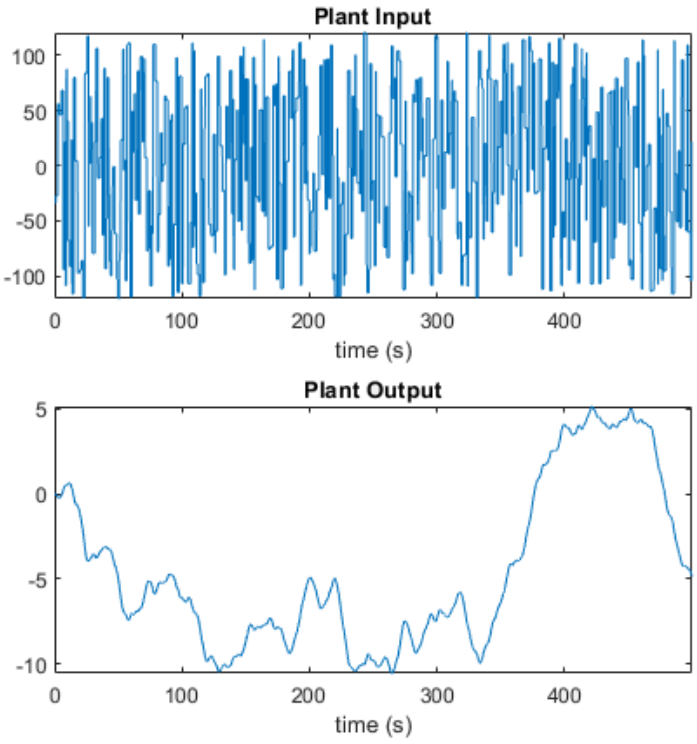
Figure 33. The training dataset of the motion process input and output.